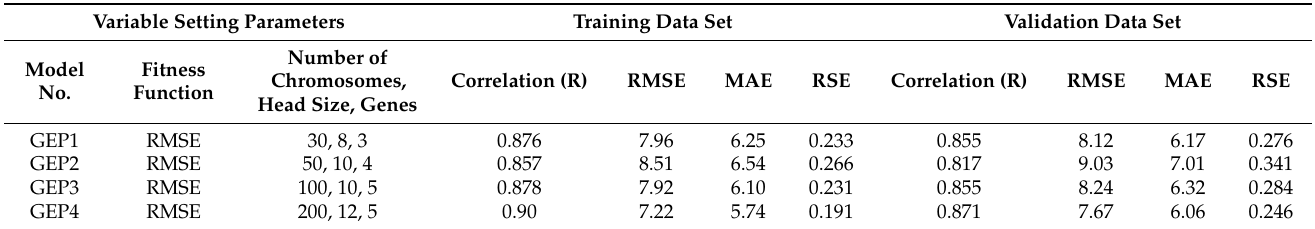
Table 5. Details of trials undertaken for hyperparameter selection for the GEP